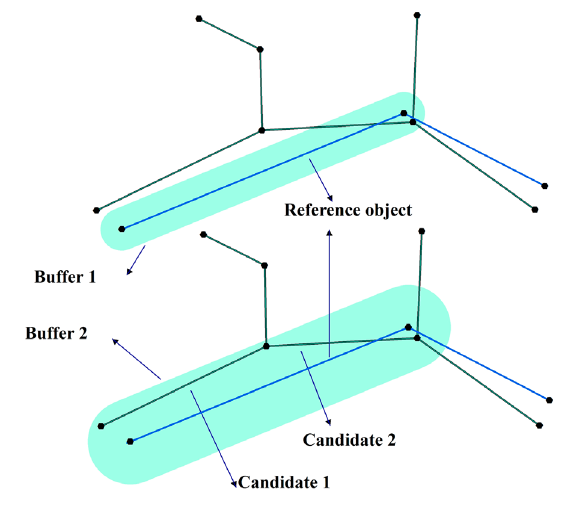
Fig. 9. Buffer expanding in the width direction